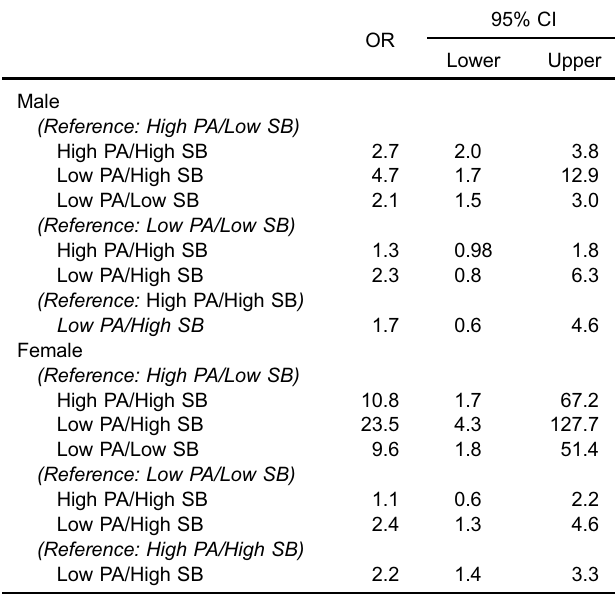
High PA/High SB